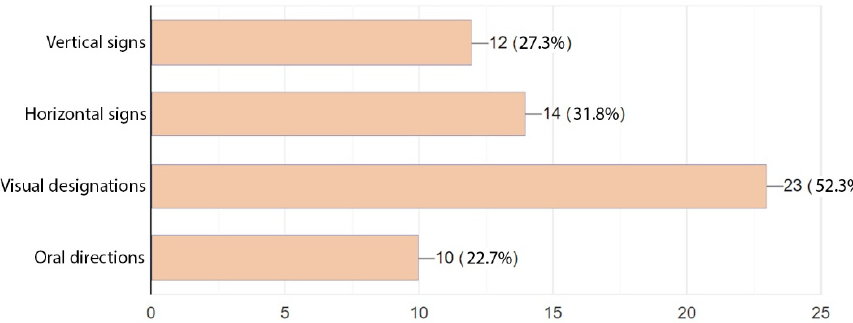
Figure 18. Preferences as to the visual identification system in a hospital—patients .